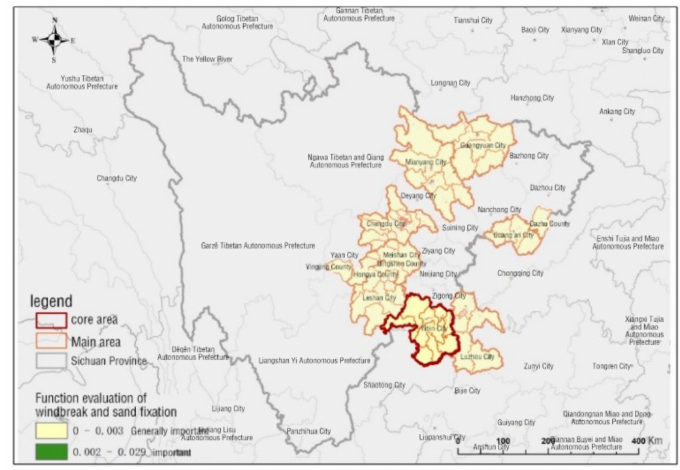
Figure 10. Windbreak and sand fixation function analysis of research areas in Sichuan Province.